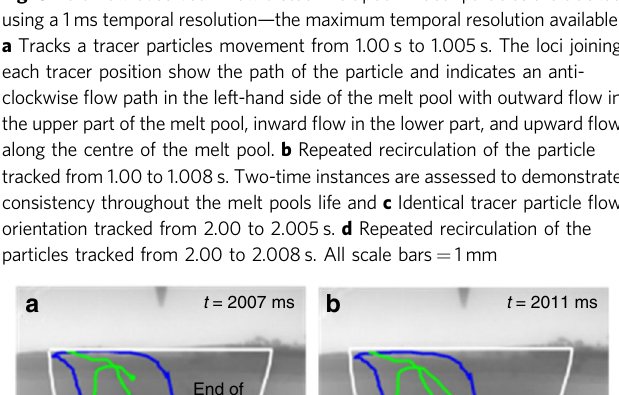
Fig. 4 Fluid fl ow observed in high S steel melt pool. Tracer particles are tracked using a 1ms temporal resolution — the maximum temporal resolution available. a Tracks two tracer particles movement from 2.00 to 2.007s. The loci joining each tracer position show the path of each particle and indicates an opposite fl ow path to that observed in Fig. 3. In the high S steel melt pool, a clockwise fl ow path is observed in the left-hand side of the melt pool with inward fl ow in the upper part of the melt pool, downward fl ow along the centre, and outward fl ow in the lower part of the melt pool. b Repeated recirculation of the particles tracked from 2.00 to 2.011s. All scale bars = 1mm